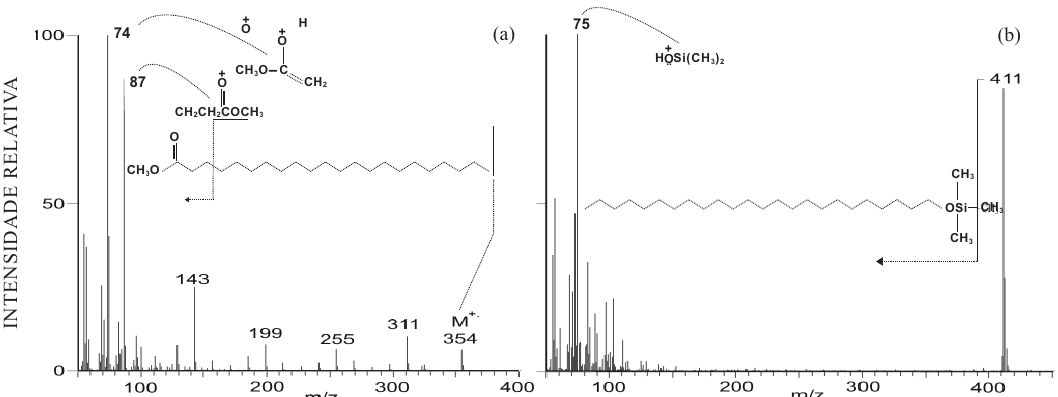
Figura 1. Espectro de massas exemplificando a identificação dos ácidos e álcoois saturados nas amostras de sedimento. Ácido docosanóico (a) e álcool tetracosanol (b), nas formas de éster metílico e trimetilsilil éter,